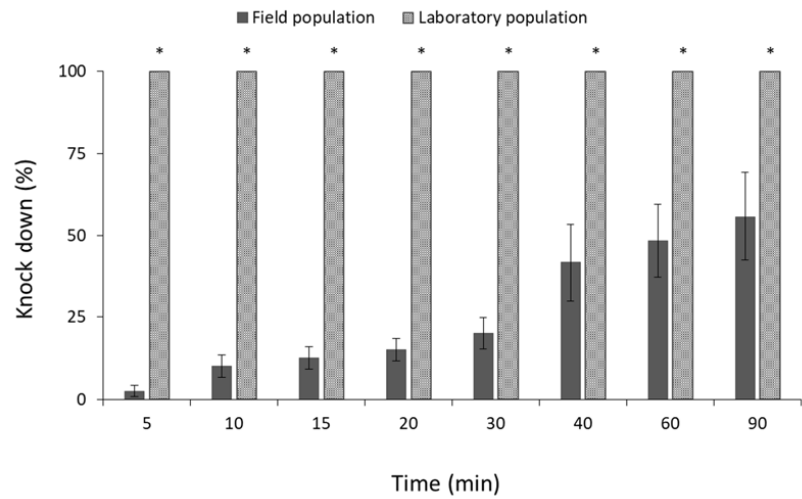
Figure 11. Mean (% ± SE) of knocked-down adults of field and laboratory populations of S. zeamais , after exposure to phosphine at 3000 ppm for different observation intervals (in min). Within each exposure interval, means with asterisk (*) indicate significant differences between the populations, according to Students’ t –test at p < 0.05.